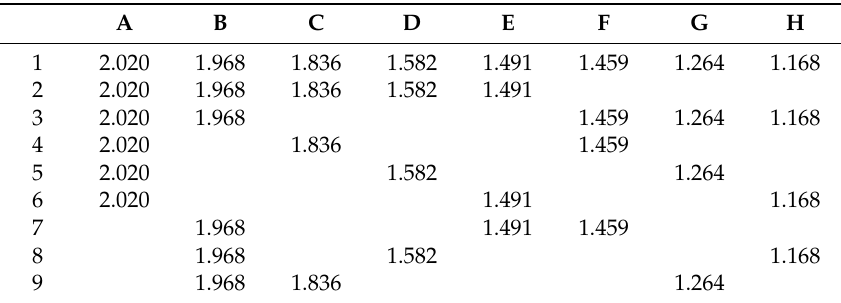
Table 5. The Mahalanobis space ( MS) based on the inner race.